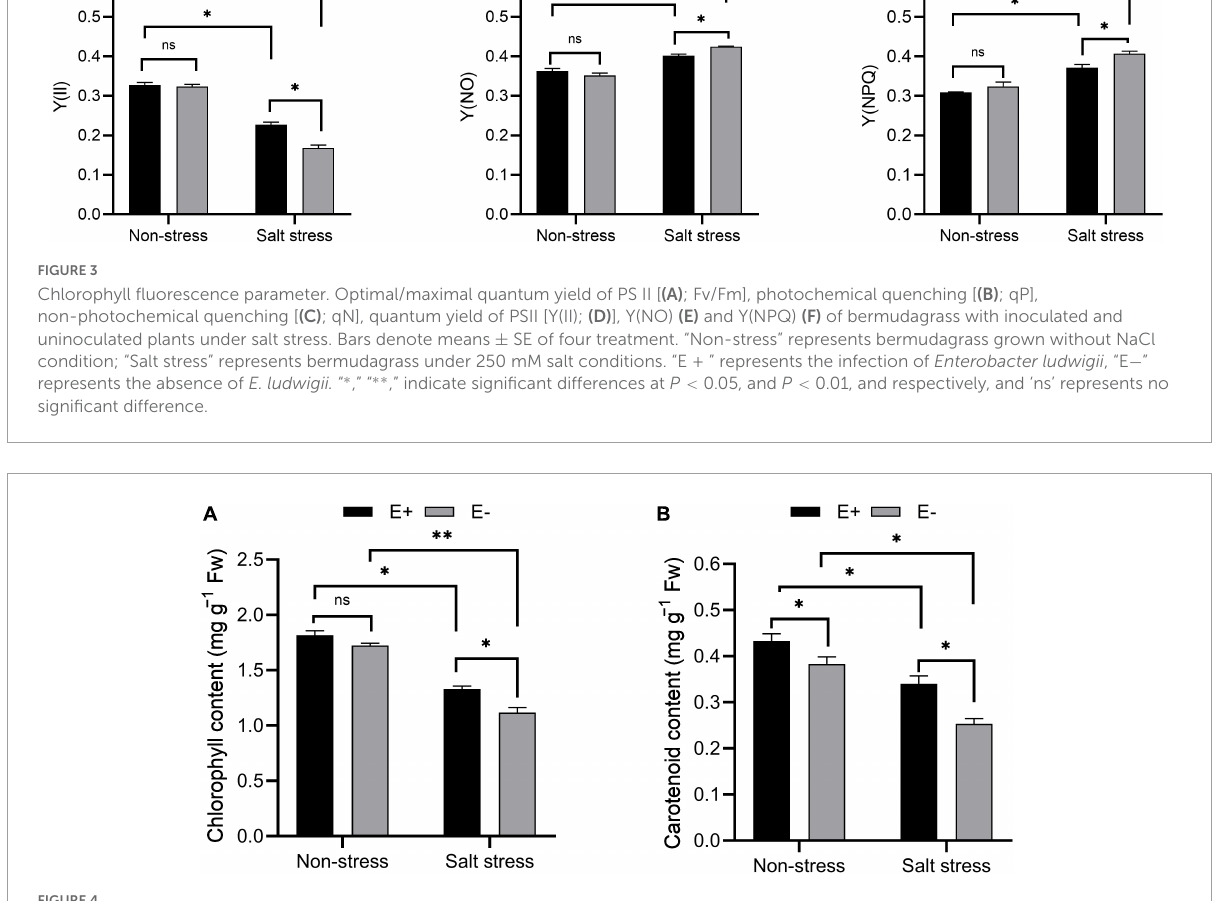
was not significantly different among plants grown with E − . Under non-salt stress conditions, the ratio in plants grown with E + was significantly lower than those with E–. Under SS, the K